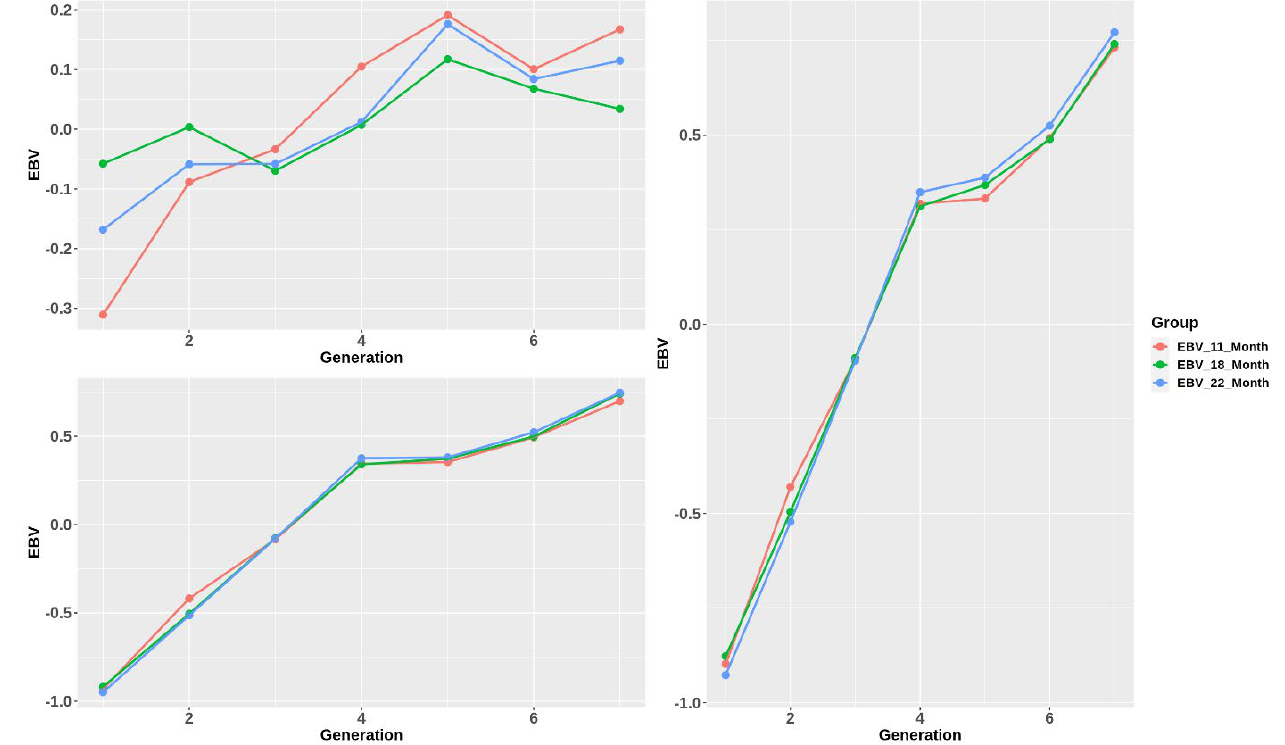
Figure 4. Standardized estimated breeding value trend over generations.